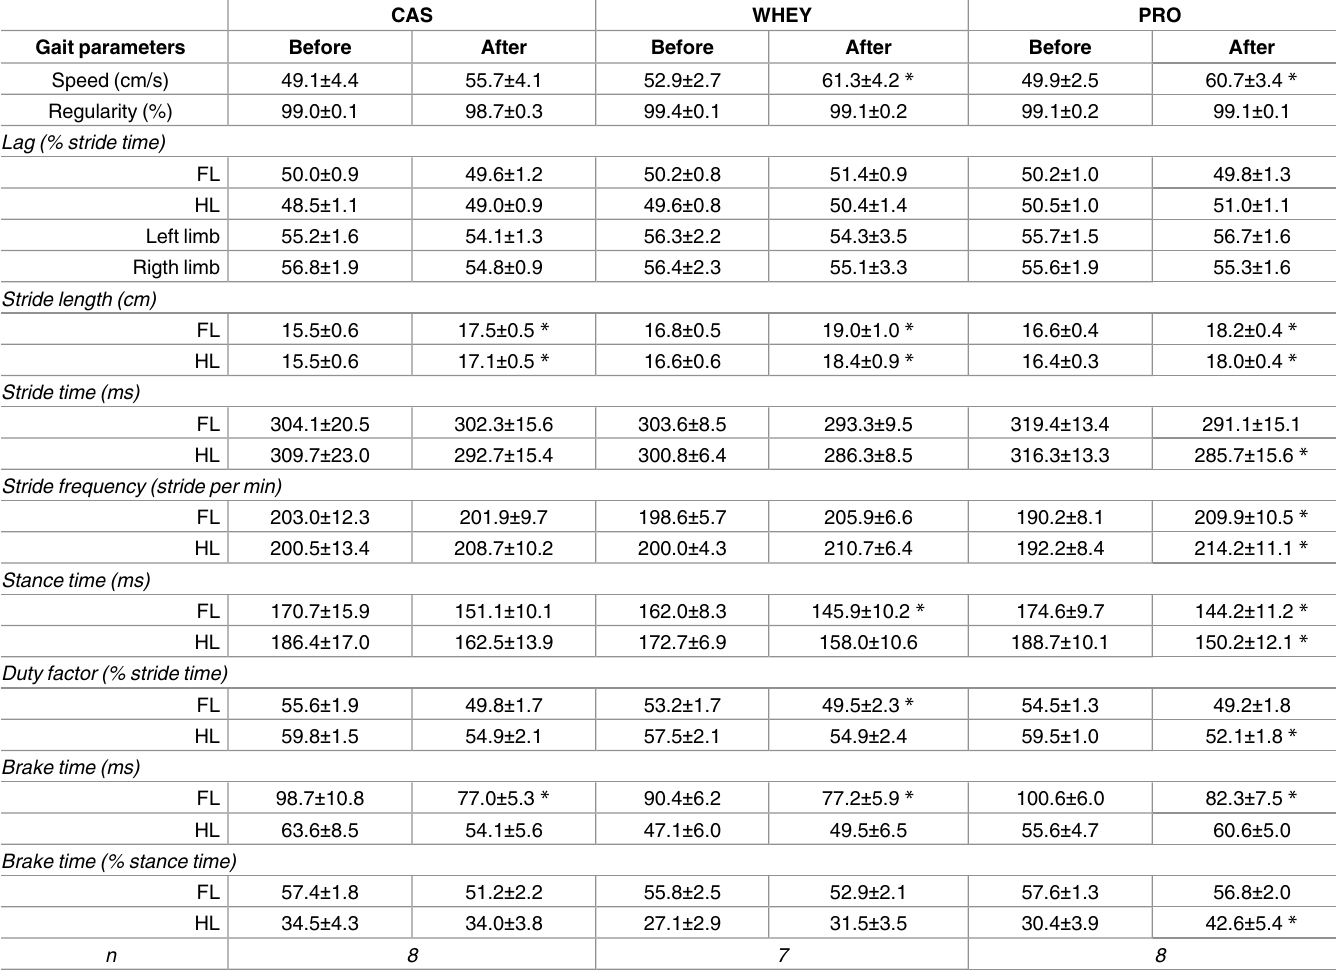
Table 8. Dynamic and static gait parameters improved in old active rats supplemented with soluble milk protein. CAS WHEY PRO Gait parameters Before After Before After Before After